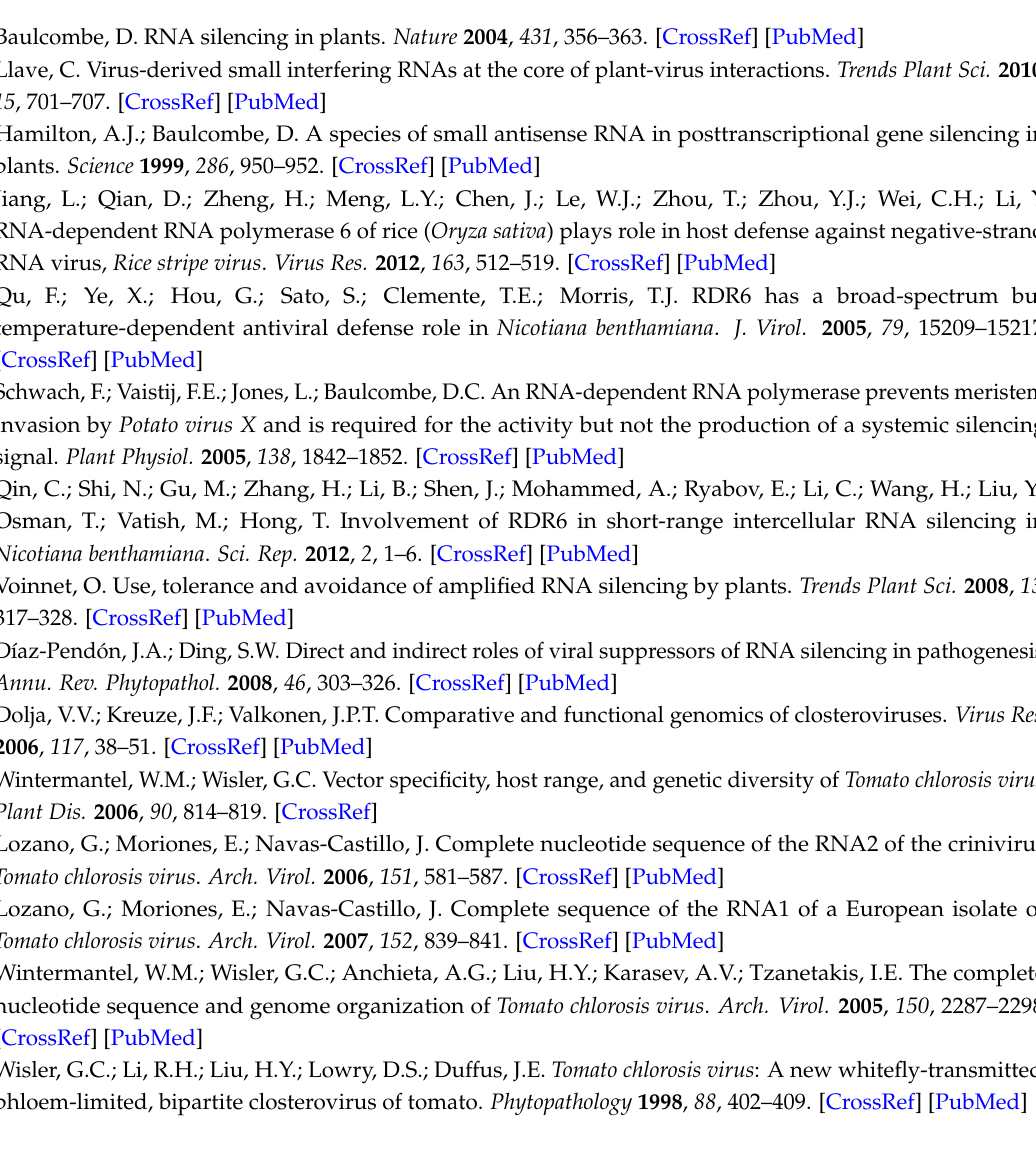
Figure S1: Diagram of the methodology used to create the p22-deficient ToCV RNA1 mutant clone, Figure S2: Lowest free energy secondary structure prediction of 3’-ends of the coding strand of ToCV RNA1, Table S1: Nucleotide sequences of primers used in this